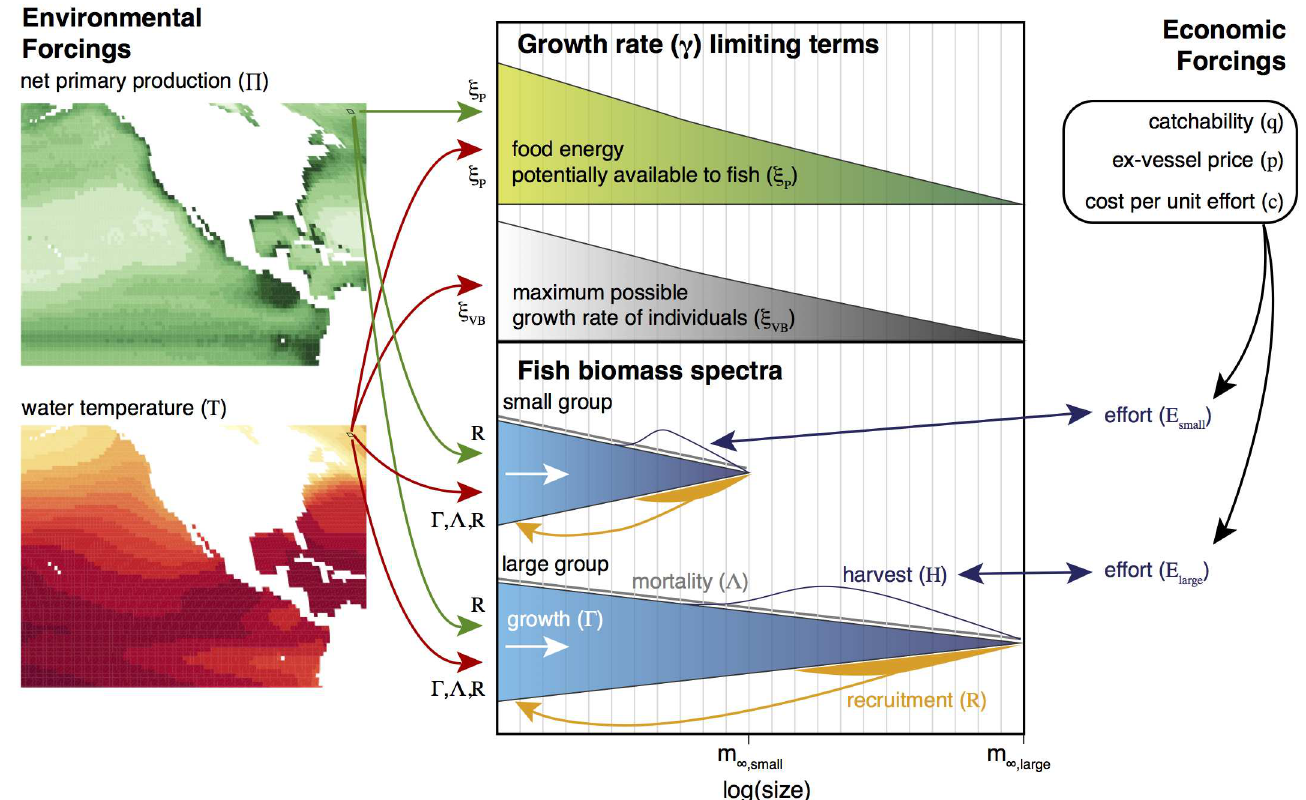
Fig 1. Schematic diagram of the main modules, components, and processesof the BOATS